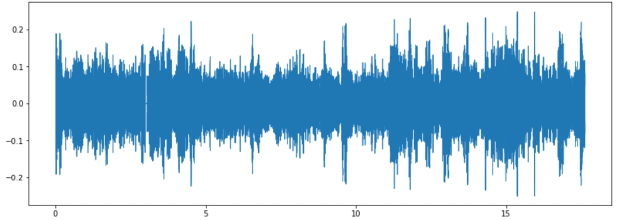
Figure 11: Audio waveform of American